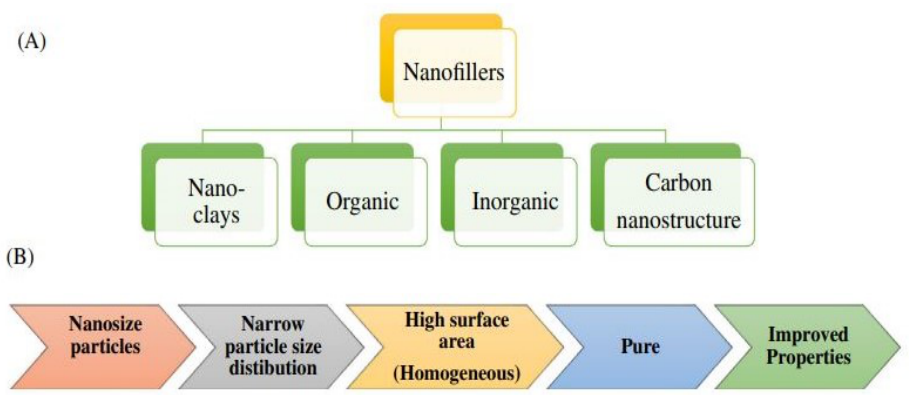
Figure-5. ( A ) Classification of nano fillers on the basis of chemical nature. ( B ) Process for incorpo- ration of nano fillers in polymer nano composites from [33] with the permission of Polymer Com- posites, WILEY.